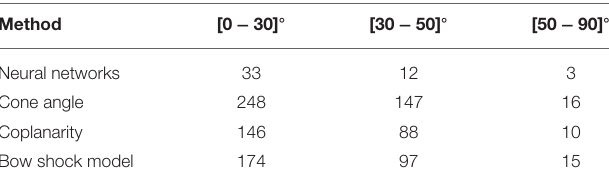
TABLE 6 | Number of misclassifications grouped in different solar zenith angles for every classification